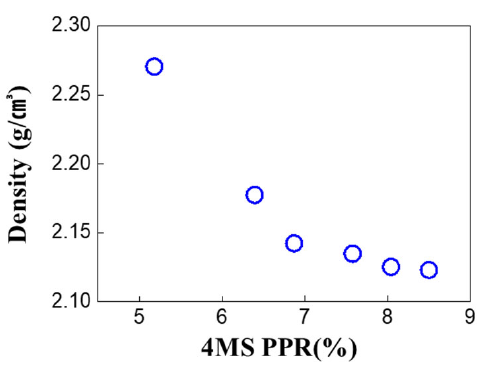
Figure 5. Results of XPS in ‐ depth analysis for three ‐ layered film with 4MS PPR 9.7%, 4MS PPR 5.2%, and 4MS PPR 9.7%. Figure 6. XRR analysis for film density after film Figure 6. XRR analysis for film density after film deposition.